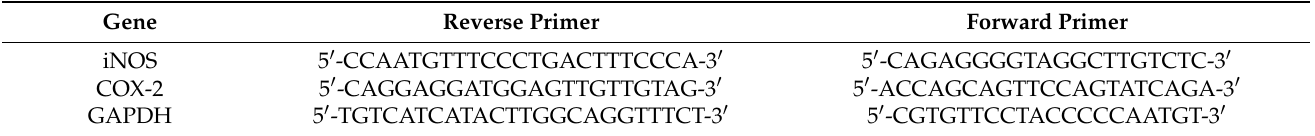
Table 10. Primers of quantitative